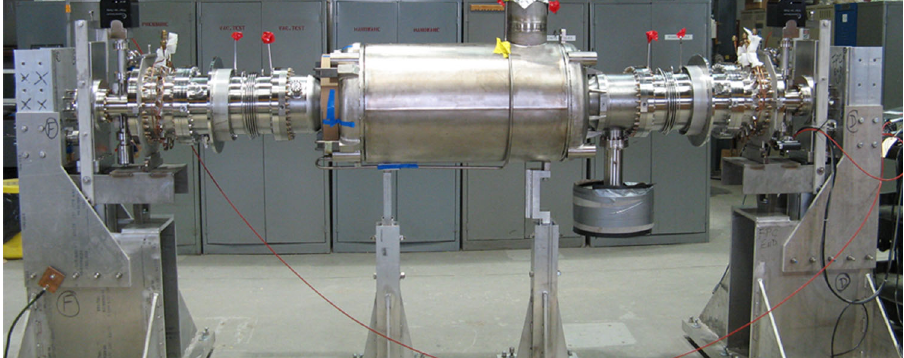
FIG. 1. (Color) The ERL cavity